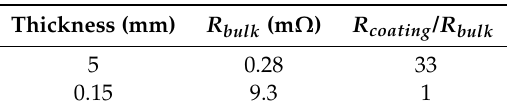
Figure 6. Back-view of the setup for coating DC resistivity measurement. Table 4. Ratio of Mo coating to MoGr bulk resistance in function of the bulk thickness. The MoGr resistivity considered is shown in Table 3.